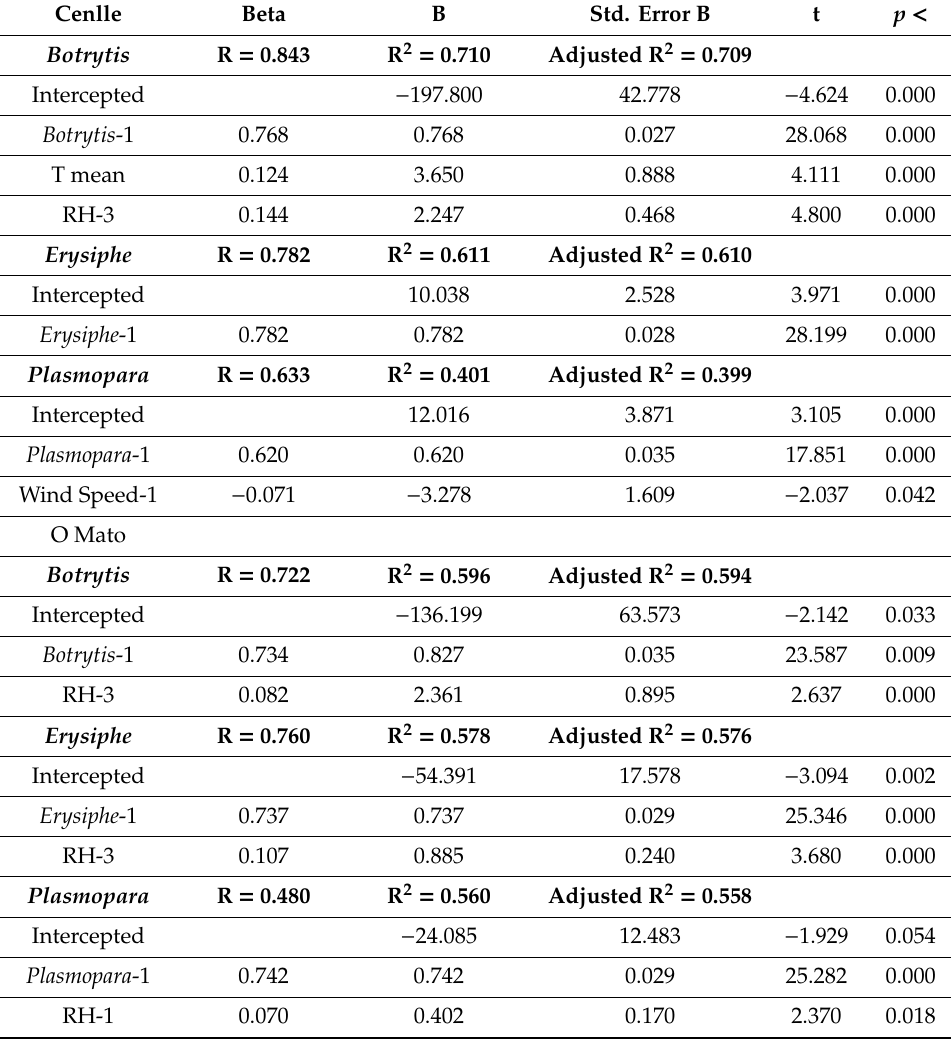
Table 6. Botrytis , Erysiphe , and Plasmopara spore concentrations regression